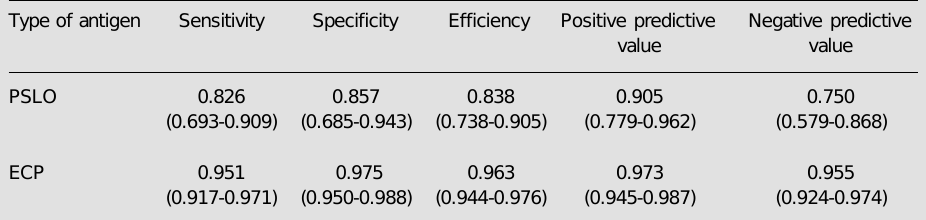
Table 1 - Diagnostic features of the indirect hemagglutination test using two different antigens for the detection of anti-SLO antibodies in the study of 546 serum samples. PSLO, Purified streptolysin O with no pretreatment; ECP, extracellular products of alkali-pretreated S. pyogenes . The 95% confidence interval is indicated within